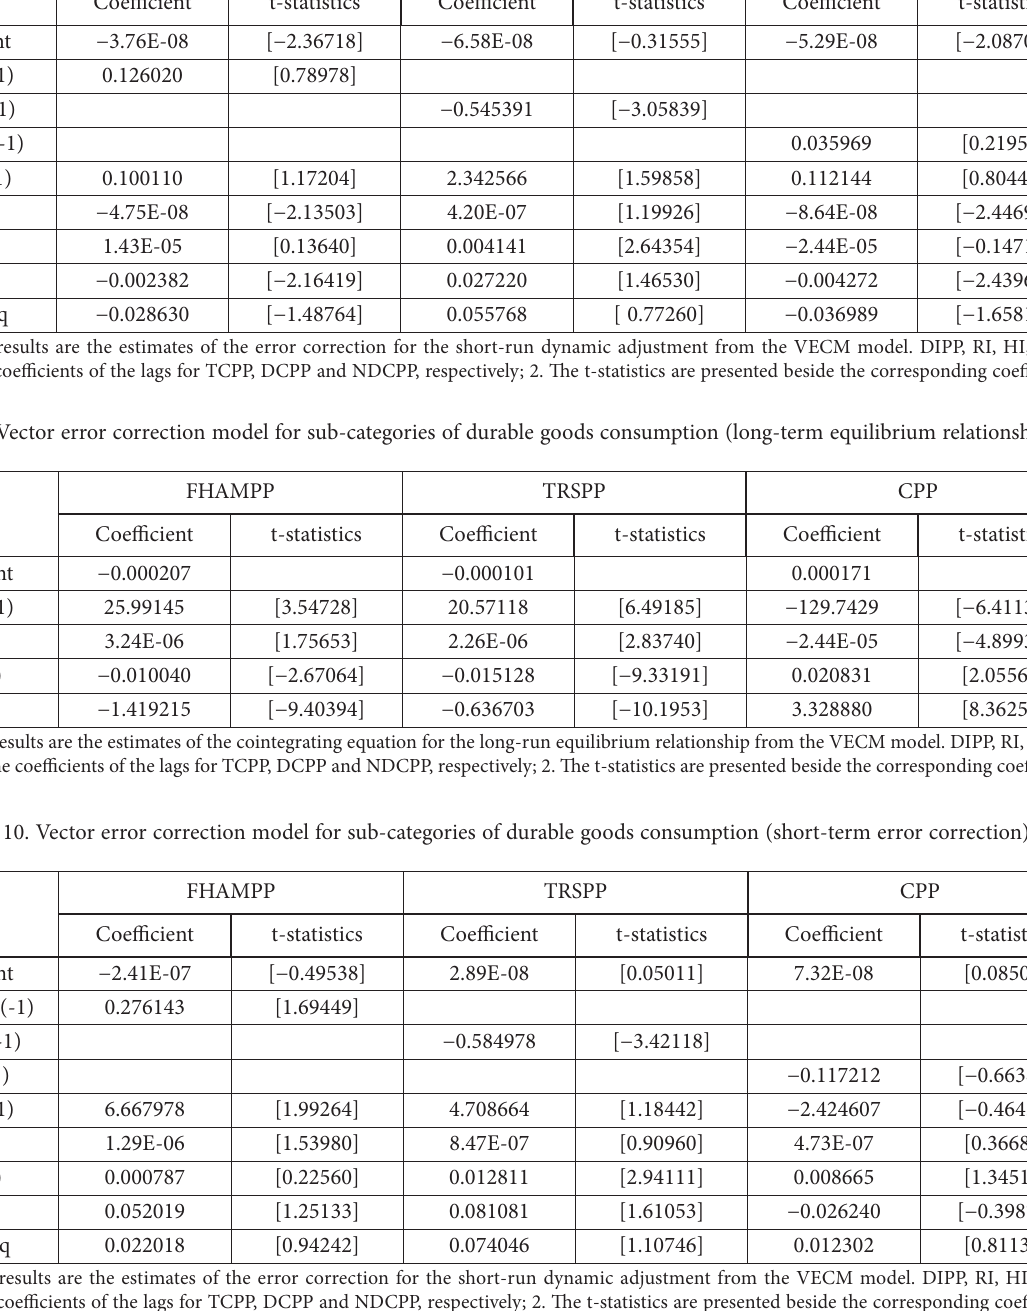
Table 8. Vector error correction model for main categories of consumption (short-term error correction) TCPP DCPP NDCPP